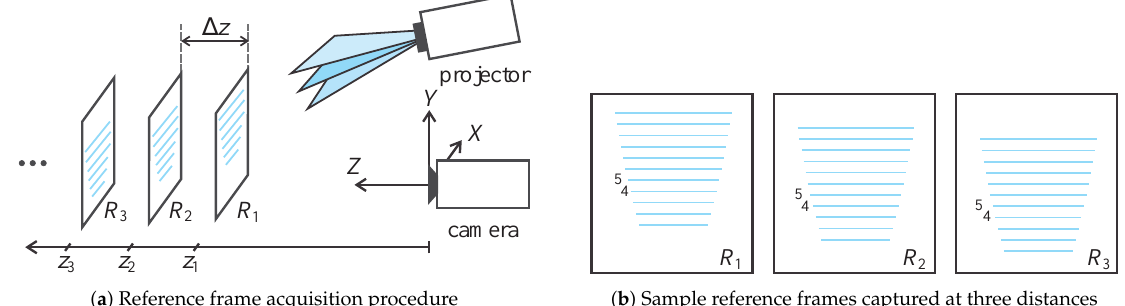
Figure 8. Illustration of the reference frame acquisition procedure: ( a ) the setup; ( b ) sample reference frames captured at distances z 1 , z 2 and z 3 . The reference frames are used to compute the depth value of each pixel segment in the labeled distortion